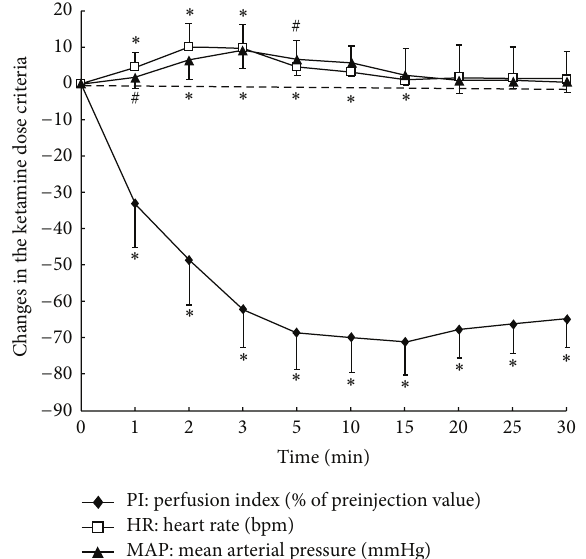
Figure 1: Changes in HR (bpm), MAP (mmHg), and percent per- fusion index (PI) following intravenous ketamine